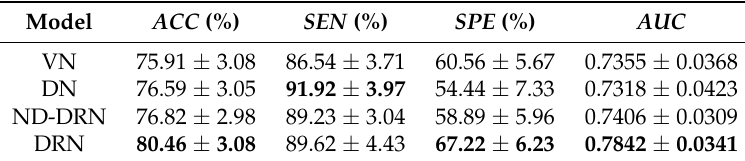
Table 5. Classification performance of different 3D models for T2 task.